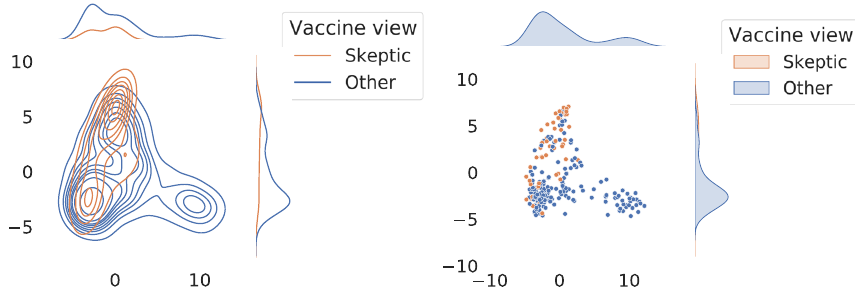
Fig. 14 Walklets representation of the users mapped to a two dimensional vector space using PCA. Colors indicate users with different vaccine views. Left: kernel density estimation of vax-skeptic users compared to other accounts over the whole test period. Right: coordinates of the users active between 5–13 May